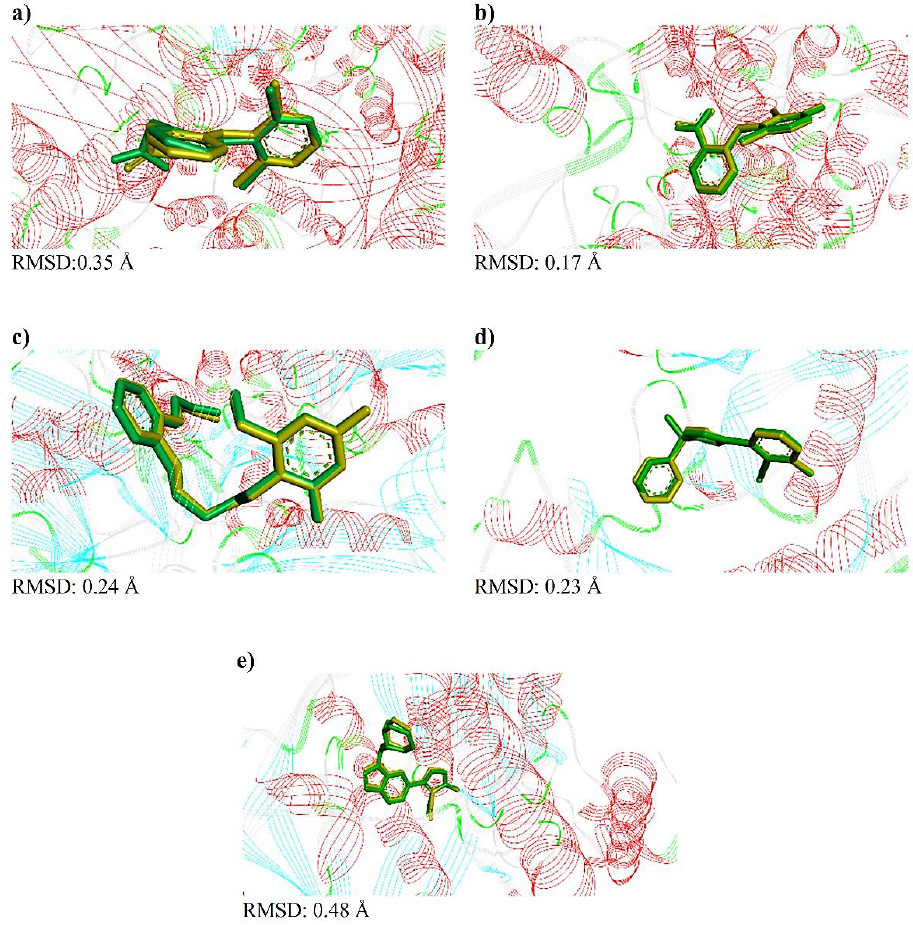
Figure 2. Redock results via Dockthor for ligands: ( a ) diclofenac, ( b ) meclofenamic acid, ( c ) MMV, ( d ) Q0Q e, ( e ) JD8. The yellow ligand corresponds to the crystallographic pose, while the green ligand corresponds to the computationally generated pose. The RMSD values for each analysis are shown below each image.